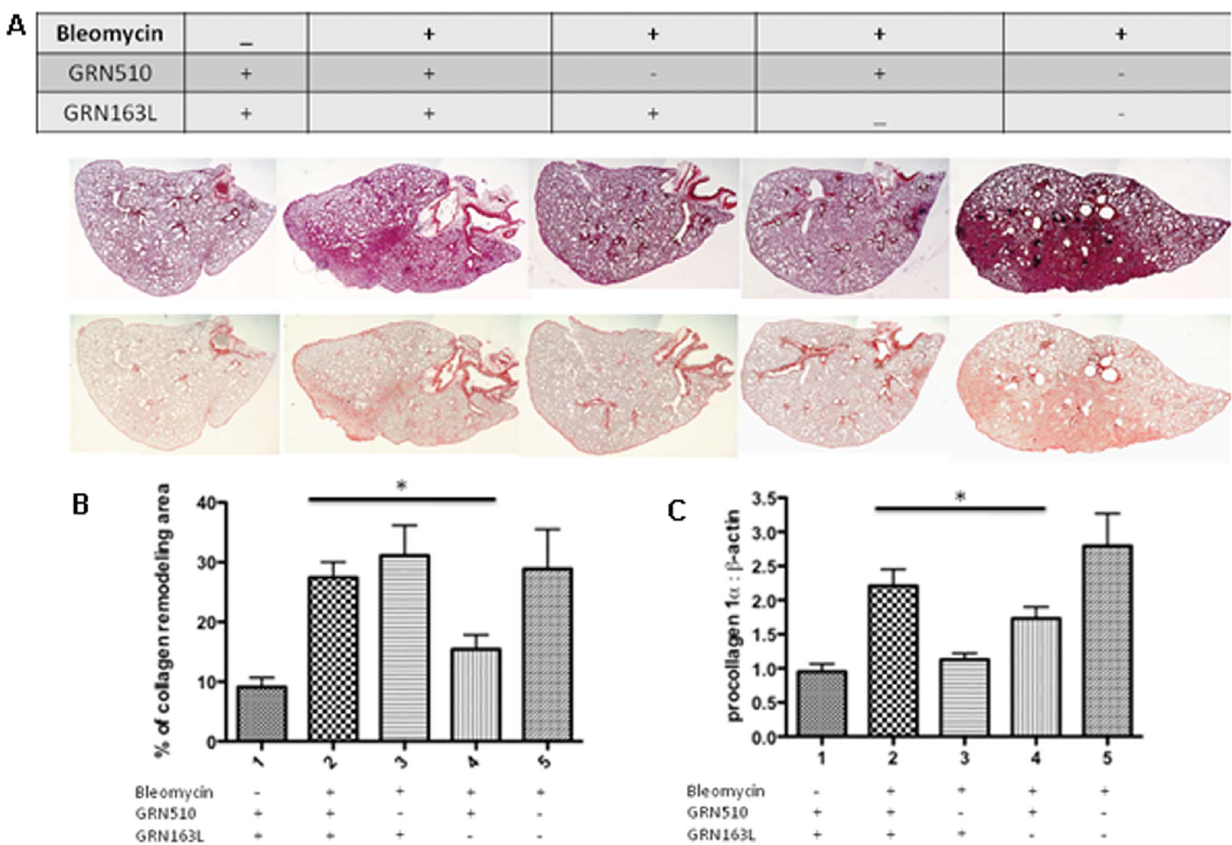
Figure 4. The GRN510-mediated protection from bleomycin-induced fibrosis is dependent on telomerase activation. Tert Het mice subjected to Bleomycin-induced fibrosis were treated with GRN510 (10 mg/kg/d) and the telomerase inhibitor GRN163L as indicated. A. Representative histological sections were obtained from the whole left pulmonary lobe taken from each animal 11 days after bleomycin-induced injury and stained with H&E (Top panel) or with picrosirius red (Lower panel). To minimize variation, samples were processed under identical conditions. B. Levels of picrosirius red staining were quantified with ImagePro software. Asterisk, * indicates significance amongst indicated groups (P=0.02, 1-way ANOVA). C. RT-PCR expression levels of procollagen1 a mRNA in the lung. Analysis was performed in triplicate for each specimen. Asterisk, * denotes significance amongst indicated groups (P=0.04, 1-way ANOVA). N=5–10 animals per group; for all plots, mean 6 SEM is shown. doi:10.1371/journal.pone.0058423.g004 PLOS ONE |